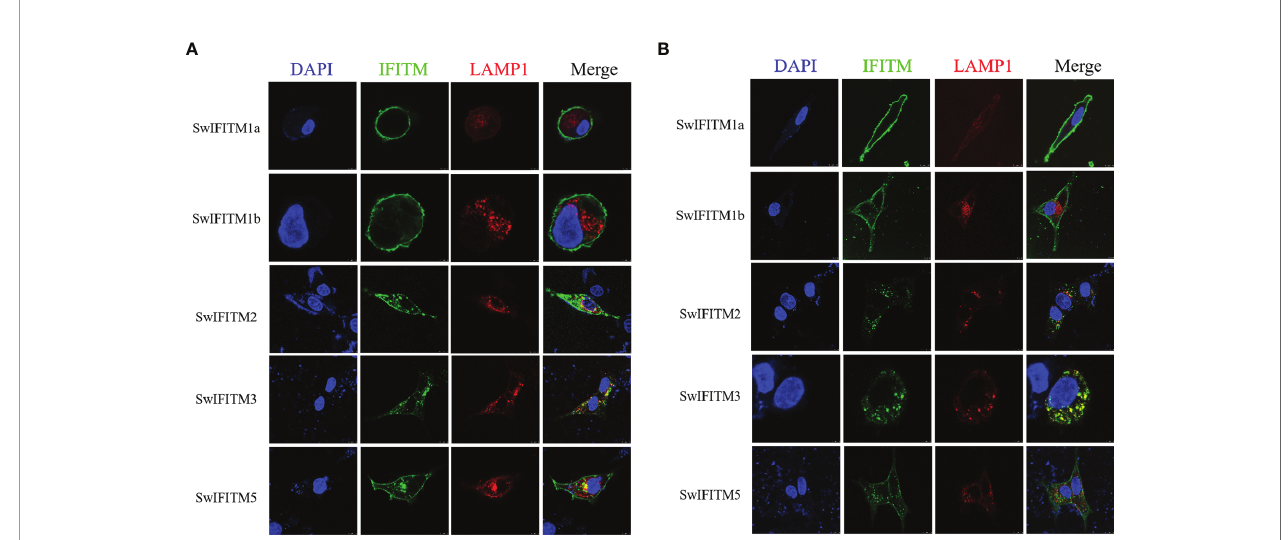
FIGURE 2 | Subcellular localization of SwIFITMs in PK-15 cells and Vero cells. The cell nucleus, expression of SwIFITM1a, -1b, -2, -3, and -5 proteins, and LAMP1- positive late endosomes (red) in (A) PK-15 cells and (B) Vero cells are indicated by blue, green, and red,